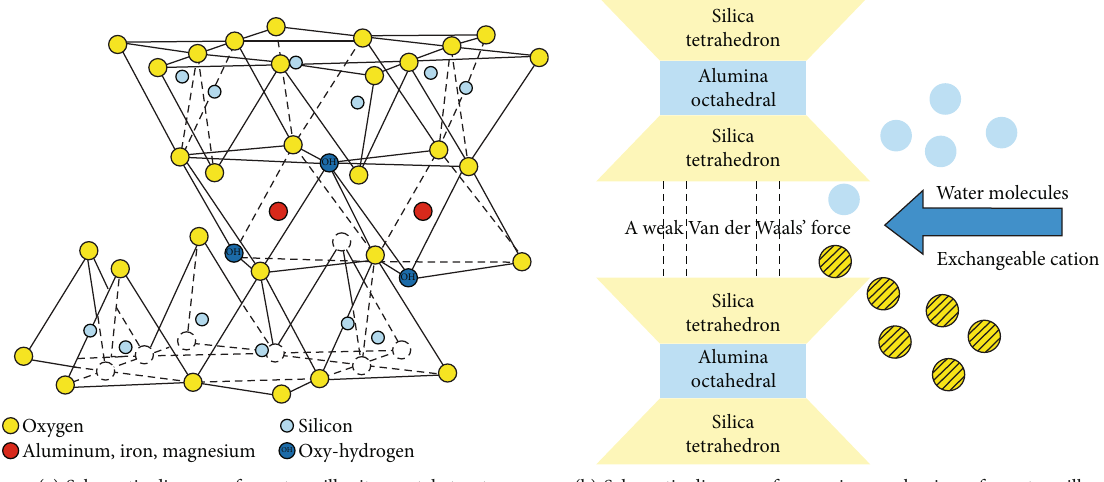
Figure 5: Structure and expansion mechanism of montmorillonite crystal layer.